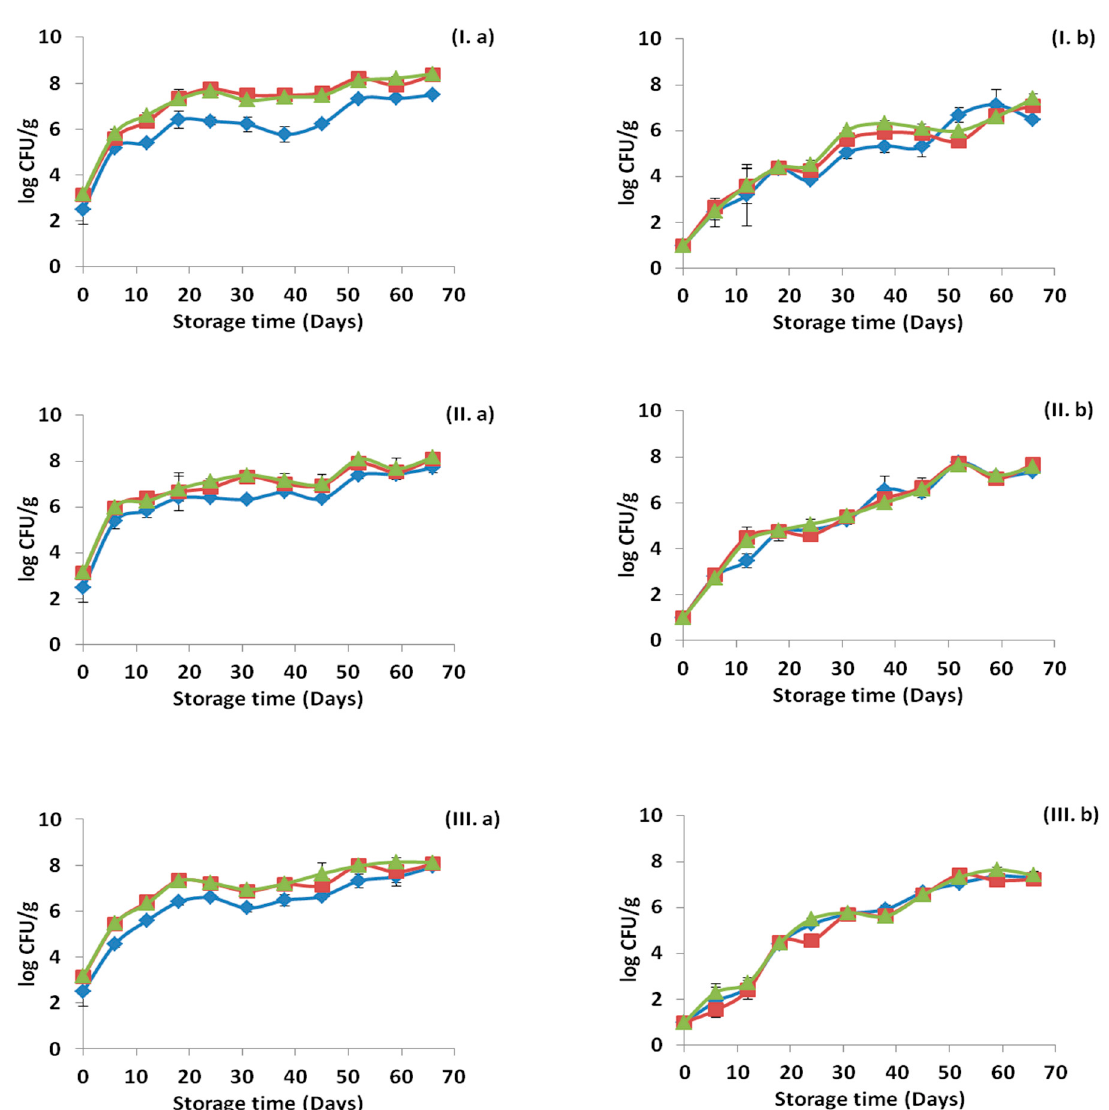
Figure 1. Growth curves of the different bacterial populations in ham stored at 4 °C for the control samples ( I ), samples with edible film free from oregano essential oil- (OEOF) ( II ) and samples with edible film supplemented with oregano essential oil- OEOS ( III ), without ( a ) and after ( b ) the high pressure processing treatment. ( ♦ ) Lactic acid bacteria, ( ■ ) lactococci/streptococci and ( ▲ ) total viable counts. The bars represent the mean values ± standard deviations.